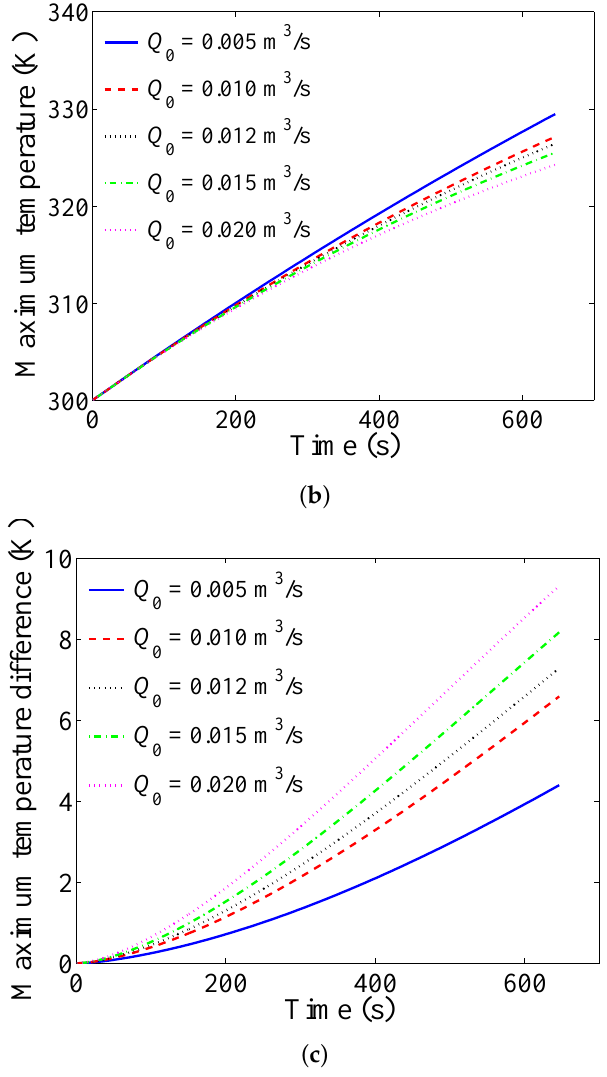
Figure 8. Comparison of results for various inlet airflow rates. ( a ) Flow rate in the cooling channel; ( b ) maximum temperature; ( c ) maximum temperature